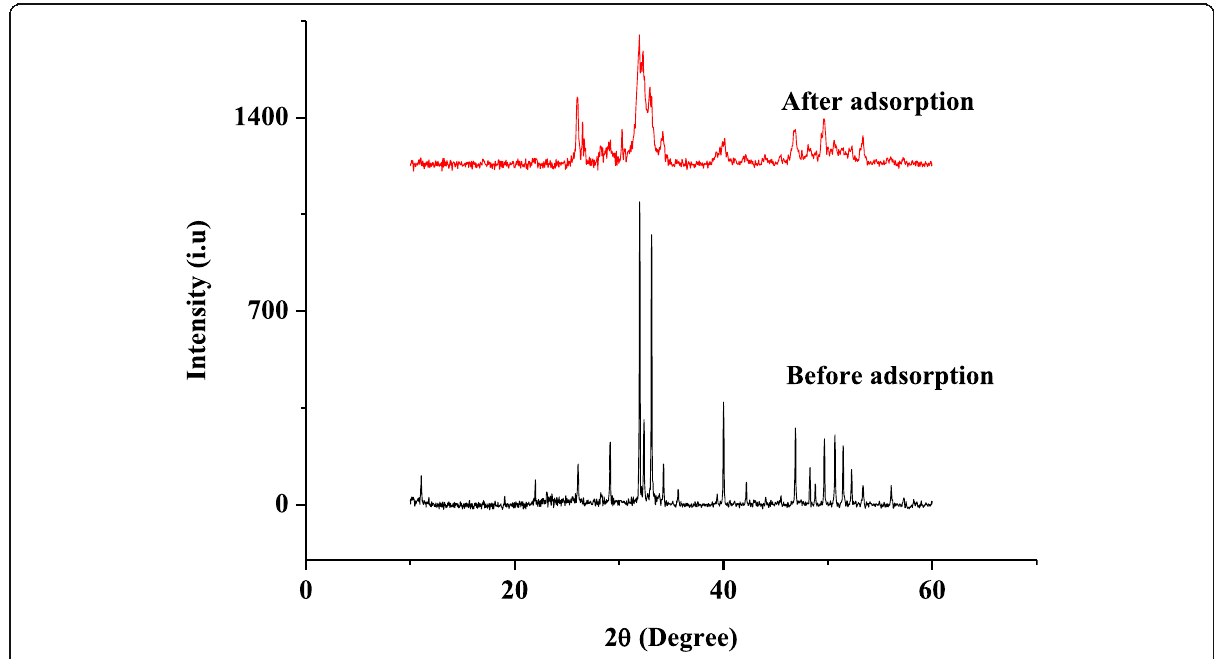
Fig. 7 XRD spectra of BMDA before adsorption and after